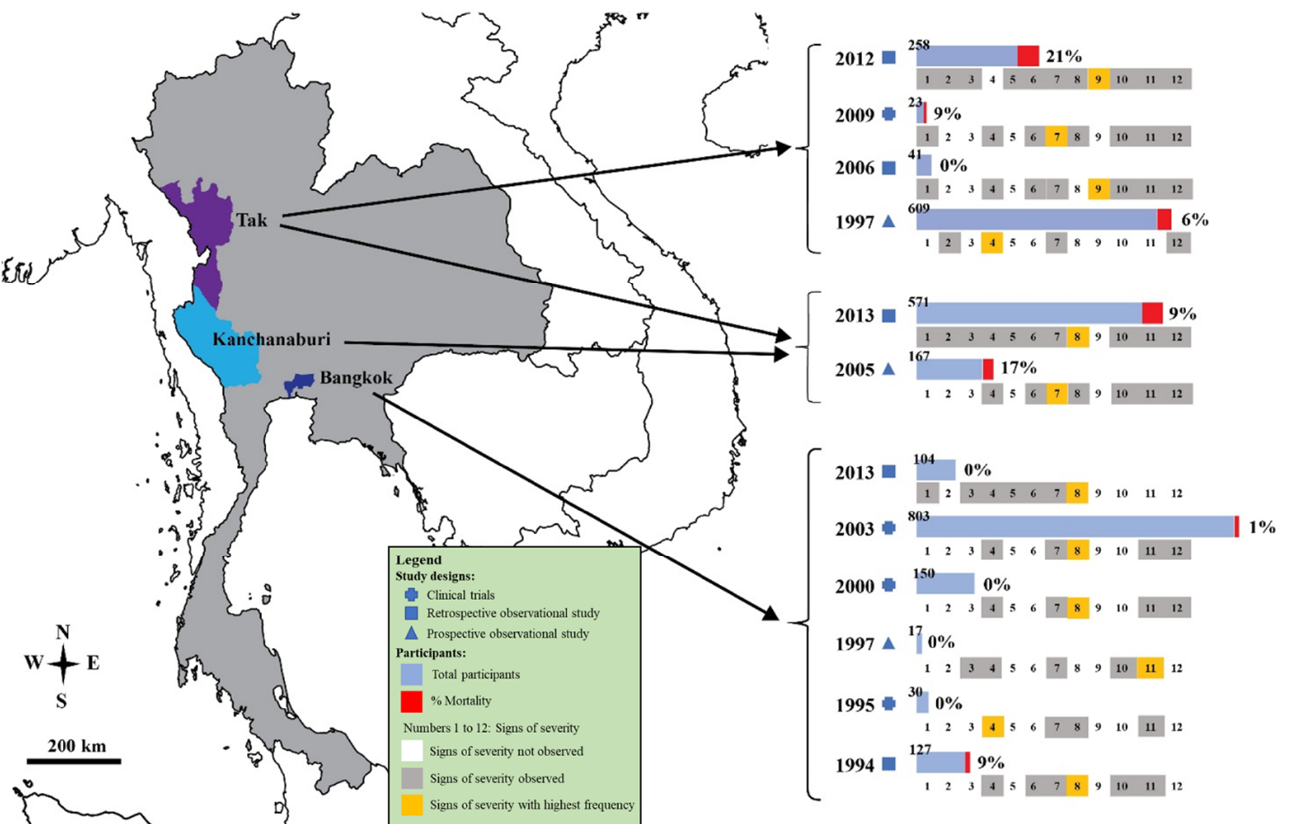
Figure 2. Details of signs of severity identified in the Thai population with malaria. Signs of severity: 1 acidosis; 2 convulsions; 3 DIC/bleeding; 4 hyperparasitemia; 5 hypoglycemia; 6 hypotension/shock; 7 impaired consciousness/coma; 8 jaundice; 9 prostrations; 10 pulmonary edema/ARDS; 11 renal impairments; 12 severe anemia . The years indicated are the years of publication .